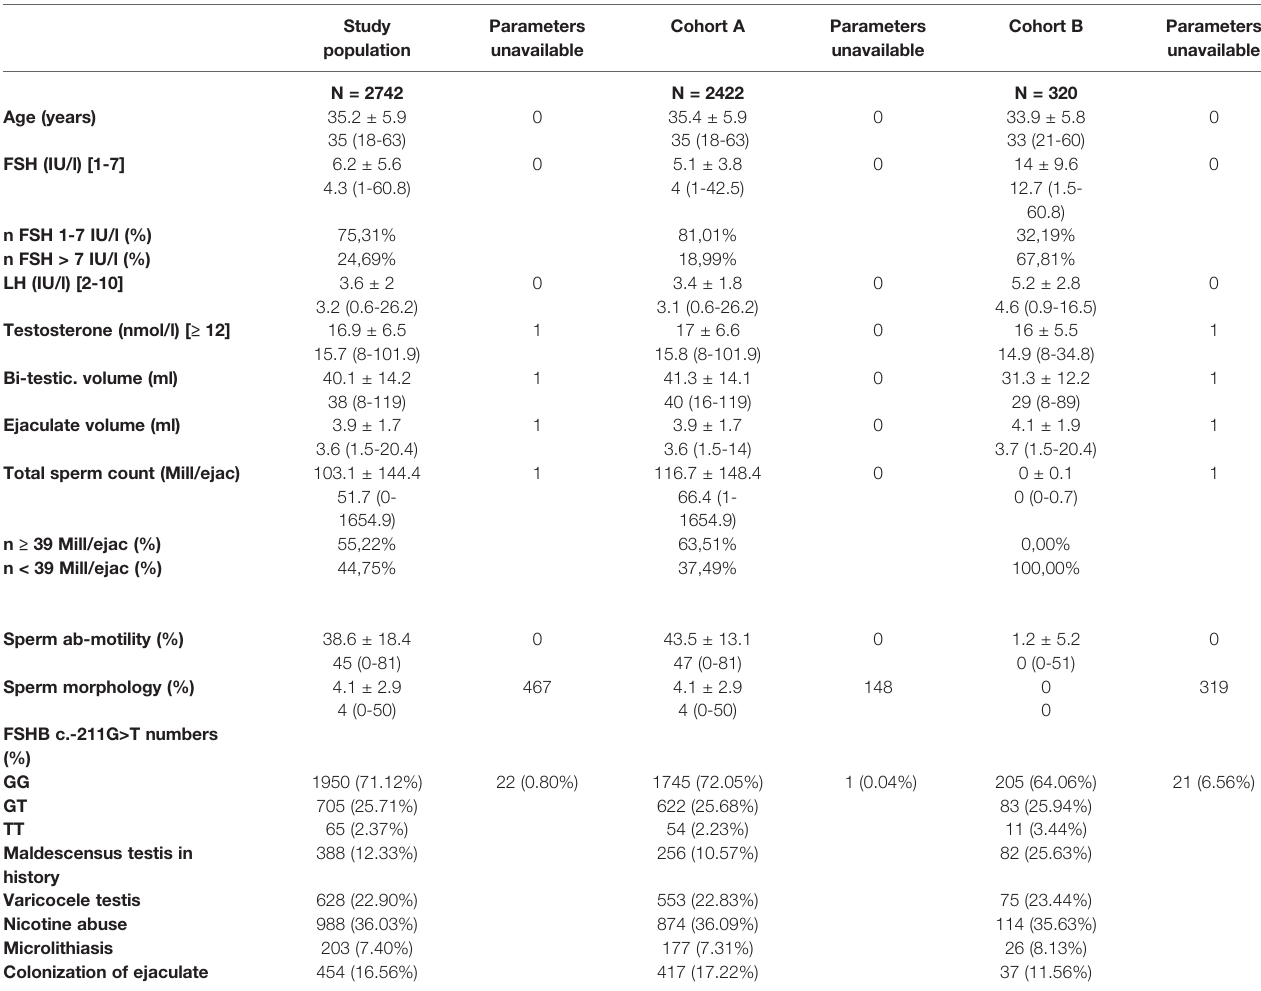
TABLE 1 | Reproductive parameters of study population (entire study population and Cohort